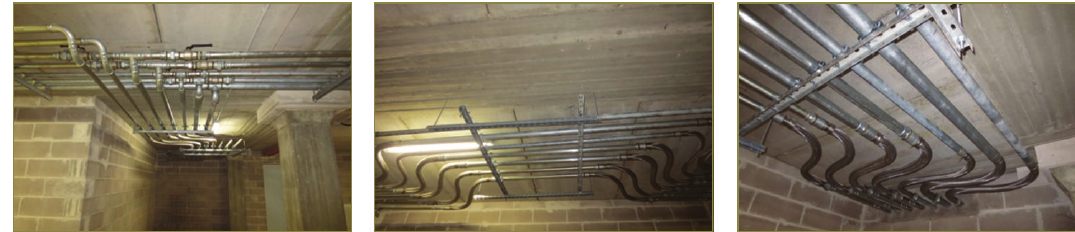
Figure 16: Images of gas pipes at an interface area between the mobile and fixed portions of the building.